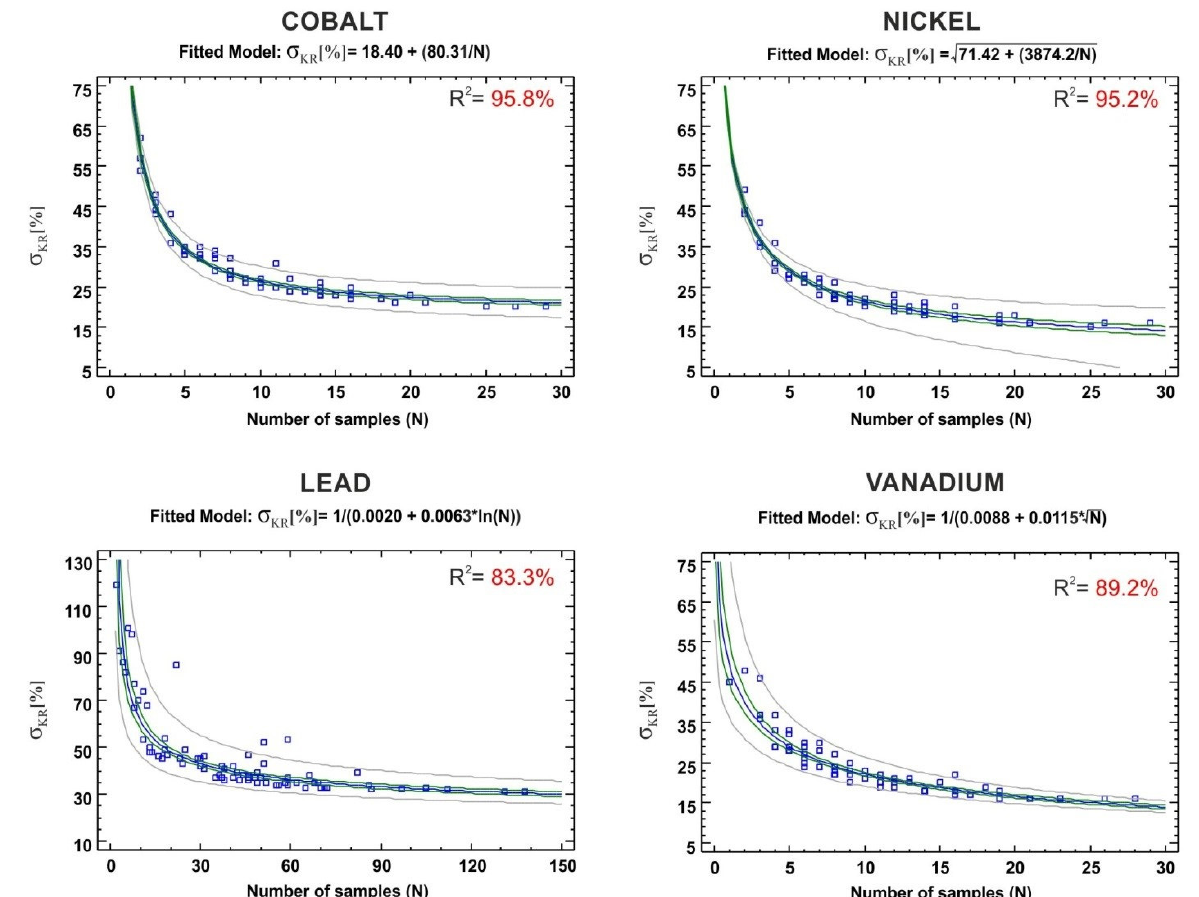
Figure 15. Plots of dependence between the relative standard kriging errors ( σ KR ) of the estimated mean abundance of elements and the number of samples in 1 km × 1 km blocks (Explanation: R 2 —coefficient of determination).